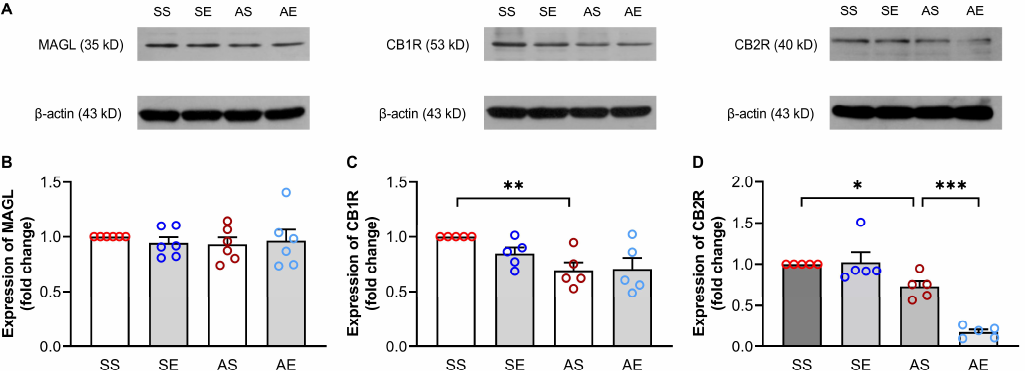
Figure 6. Effects of treadmill exercise on the expression of CB1R, CB2R and MAGL in the hip- pocampus of young adult rats. ( A ) Representative Western blots for MAGL, CB1R and CB2R in the hippocampus of rats in each group. ( B ) Summarized data show that there were no significant differences in the expression of MAGL in the hippocampus ( p > 0.05, n = 6). ( C ) Summarized data show that the expression of CB1R was decreased in the AS rats compared to the SS rats. Treadmill exercise training had no significant effects on the expression of CB1R in the hippocampus of AIE rats (** p < 0.01, n = 5). ( D ) Summarized data show that the expression of CB2R was decreased in the AS rats compared to the SS rats. The expression of CB2R was decreased in the AE rats compared to the AS rats (* p < 0.05, *** p < 0.001, n =